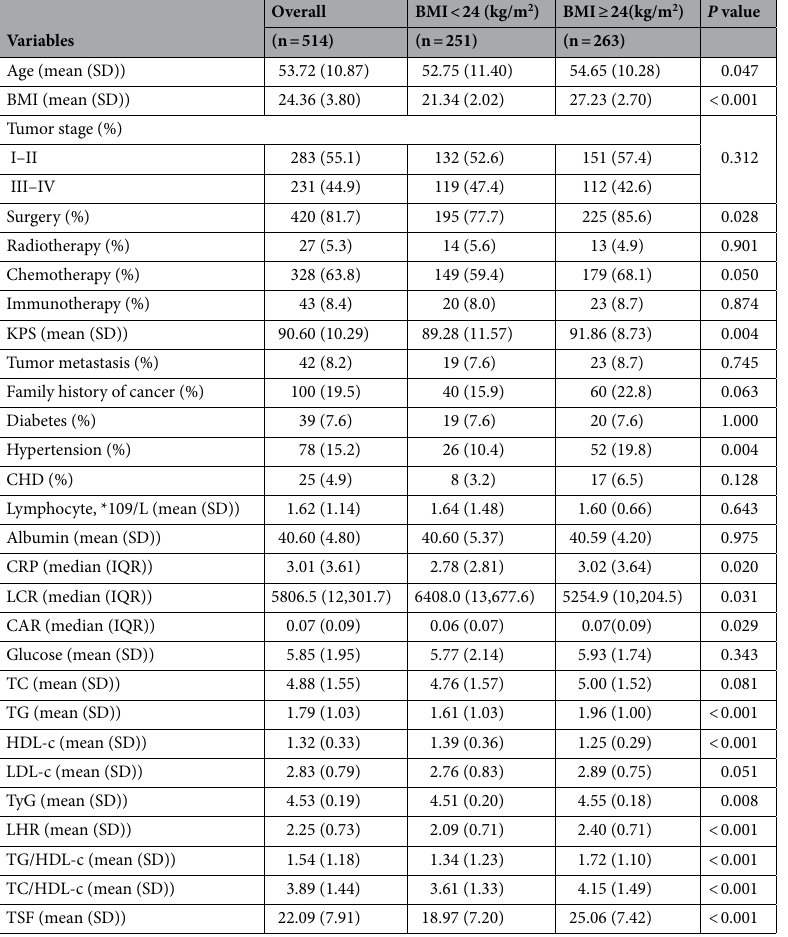
Table 1. Baseline characteristics. SD standard deviation, IQR interquartile range, BMI body mass index, KPS karnofsky performance status, CHD coronary heart disease, CRP C-reactive protein, CAR C-reactive protein